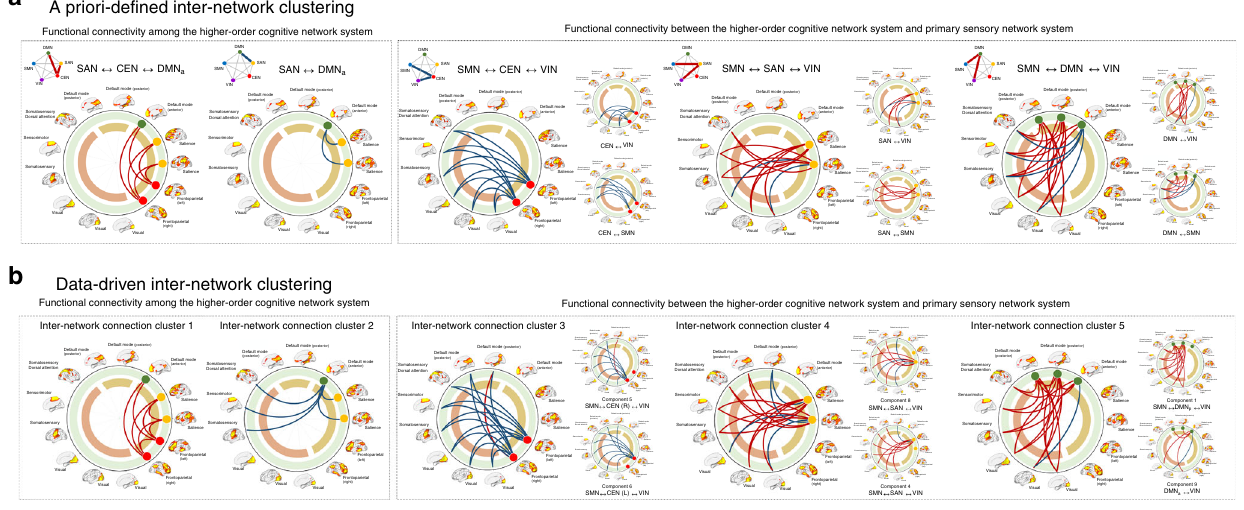
Fig. 2 A visual display of inter-network connection clusters selected in this study. a Mean connectivity strengths of the positive functional coupling of the SAN – CEN – DMN a and negative functional coupling of SAN – DMN a were selected as the two outcome variables for functional connectivity among the higher-order cognitive network system. Mean connectivity strengths of the SMN – CEN – VIN, SMN – SAN – VIN, and SMN – DMN – VIN were also calculated as the three outcome variables for functional connectivity between the higher-order cognitive network system and primary sensory network system. b Five neurobiologically meaningful inter-network connection clusters were selected from a total of 78 inter-network functional connectivity pairs using factor analysis (see also Supplementary Table 2). The two inter-network connection clusters in the left represent functional connectivity among the higher-order cognitive networks, including the CEN, SAN, and DMN a . The three inter-network connection clusters on the right indicate functional connectivity between each of the networks belonging to the higher-order cognitive network system and the primary sensory network system, including the DMN and VIN. Red and blue lines indicate the positive and negative coupling of networks, respectively. SAN salience network, DMN default mode network, DMN a default mode network, anterior, CEN central executive network, SMN sensorimotor network, VIN visual